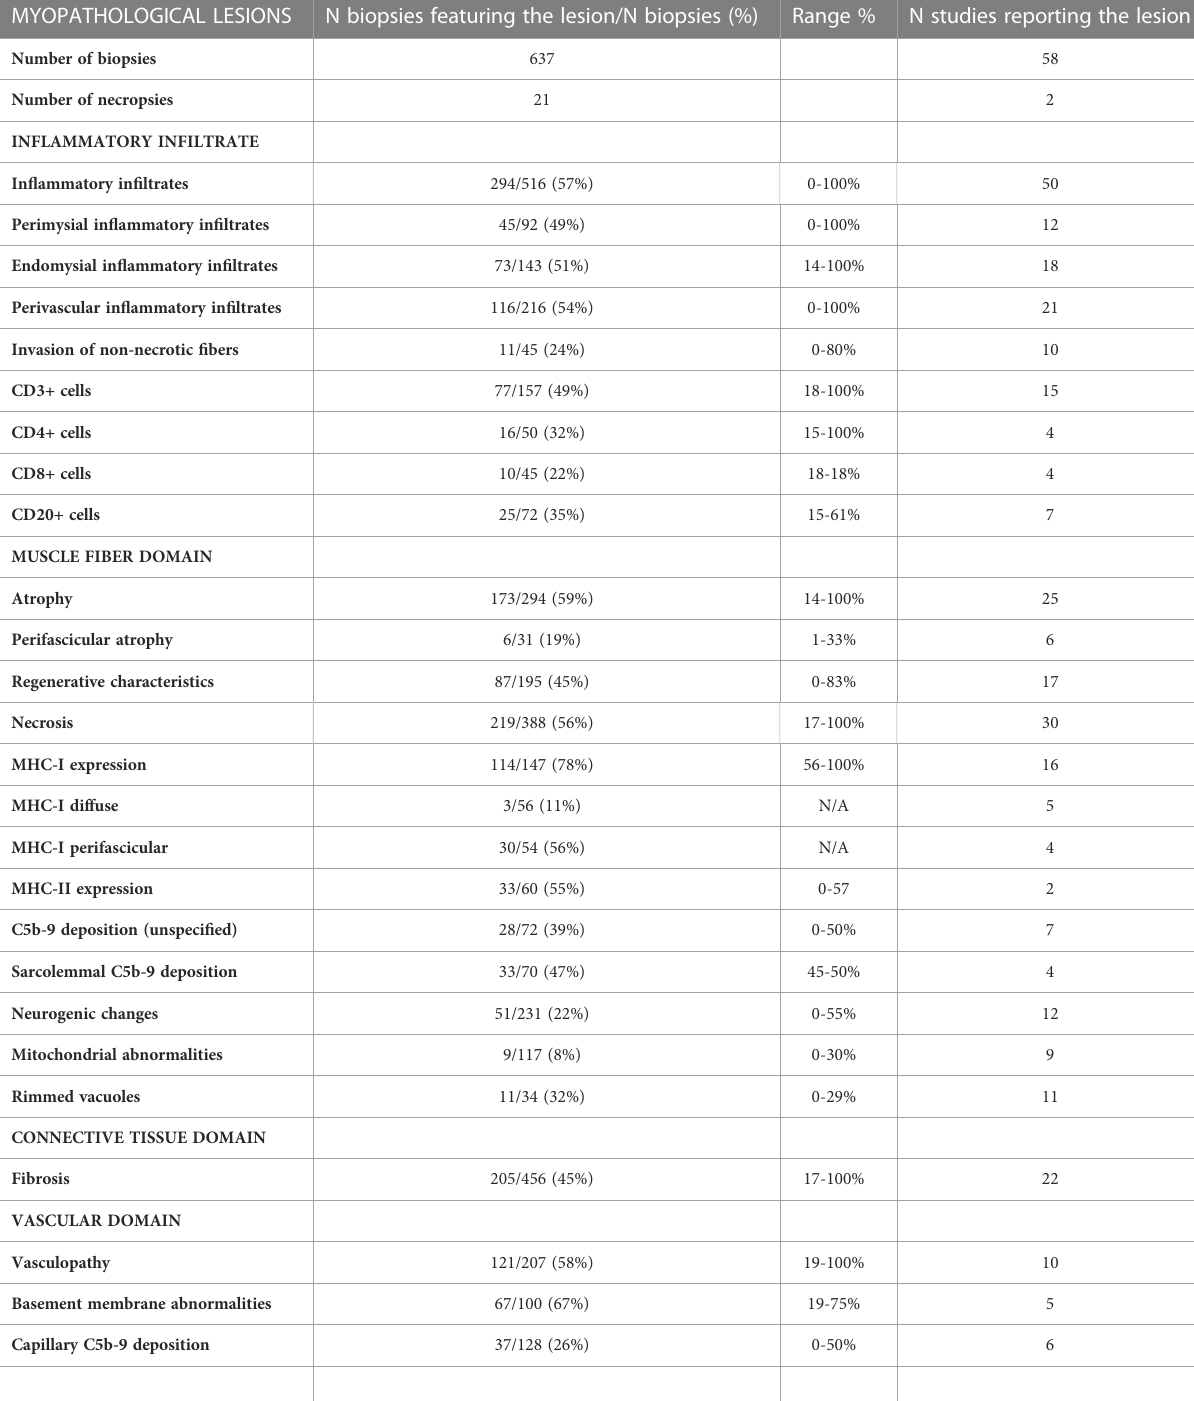
TABLE 3 Muscle histopathological features of